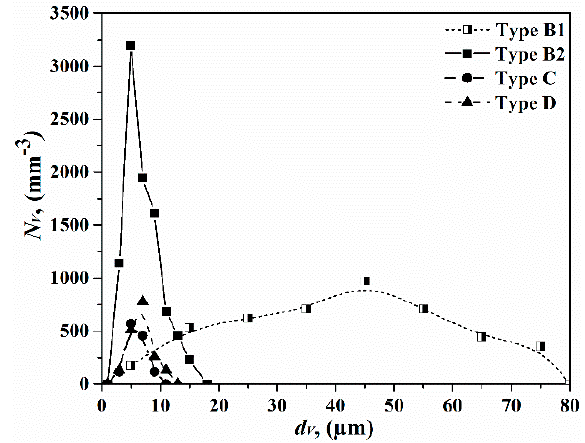
Figure 1. Particle size distributions of type B, type C, and type D inclusions in FeV alloys.